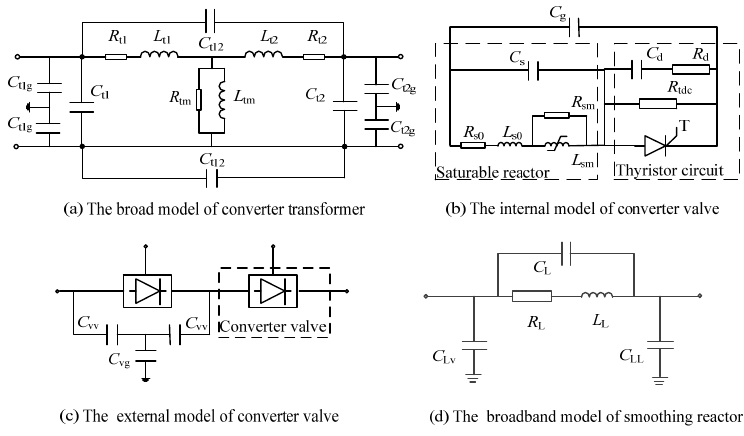
Figure 3. The Broadband Models of Valve